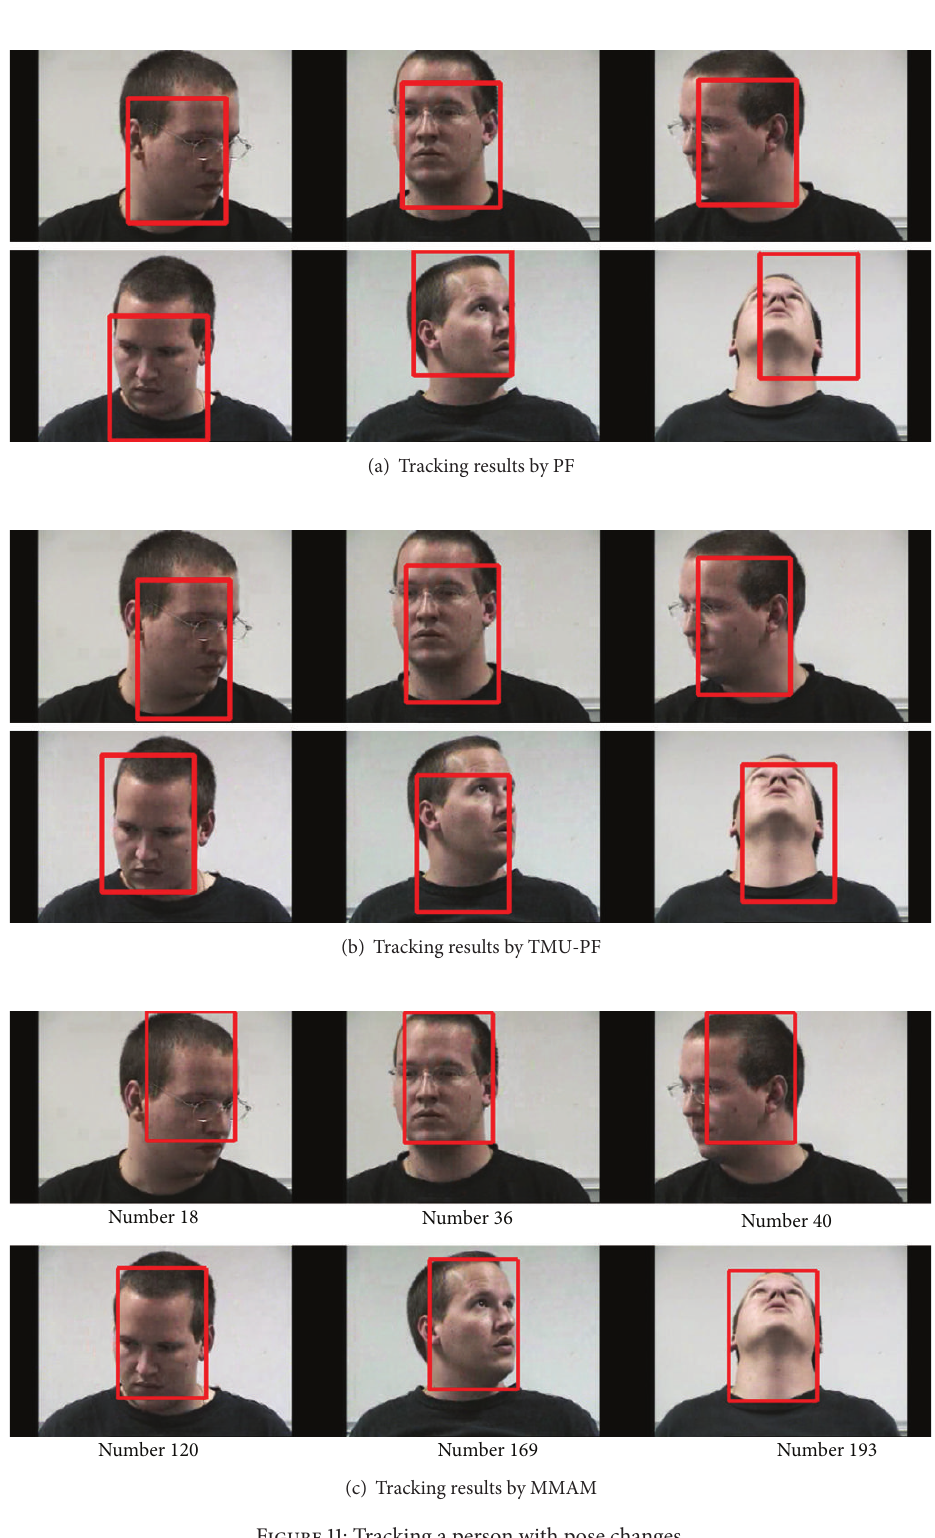
Figure 11: Tracking a person with pose